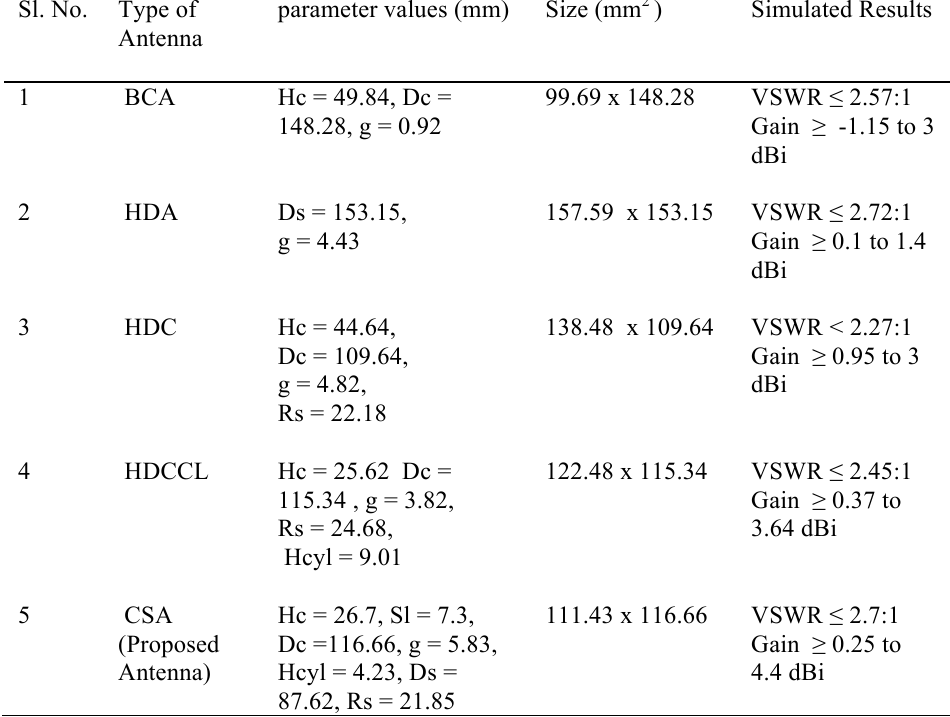
Table 1: Results of Simulation of Antenna Configurations studied in this paper